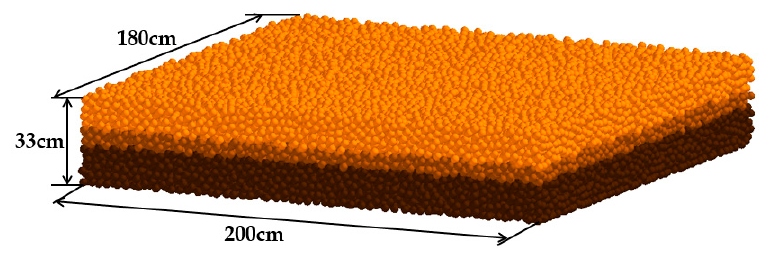
Figure 5. Soil structure model.